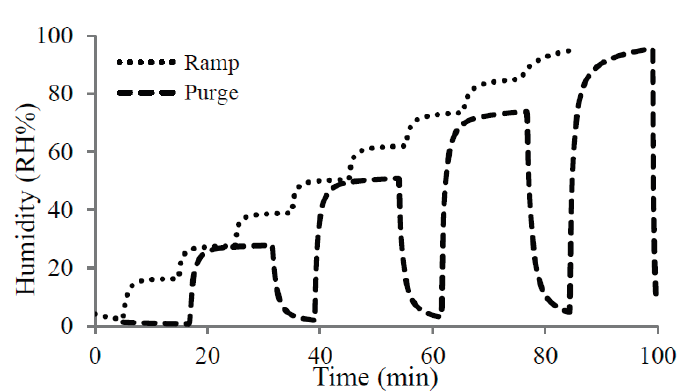
Figure 8. Ramp and purge experiment for the commercial sensor.